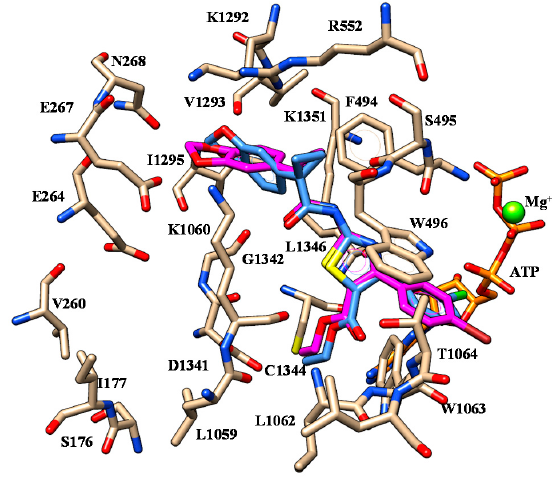
Figure 8. Selected docking mode of 3 (C atom; magenta) and 4 (C atom; light blue) within the modelled F508del-CFTR. The most important residues are